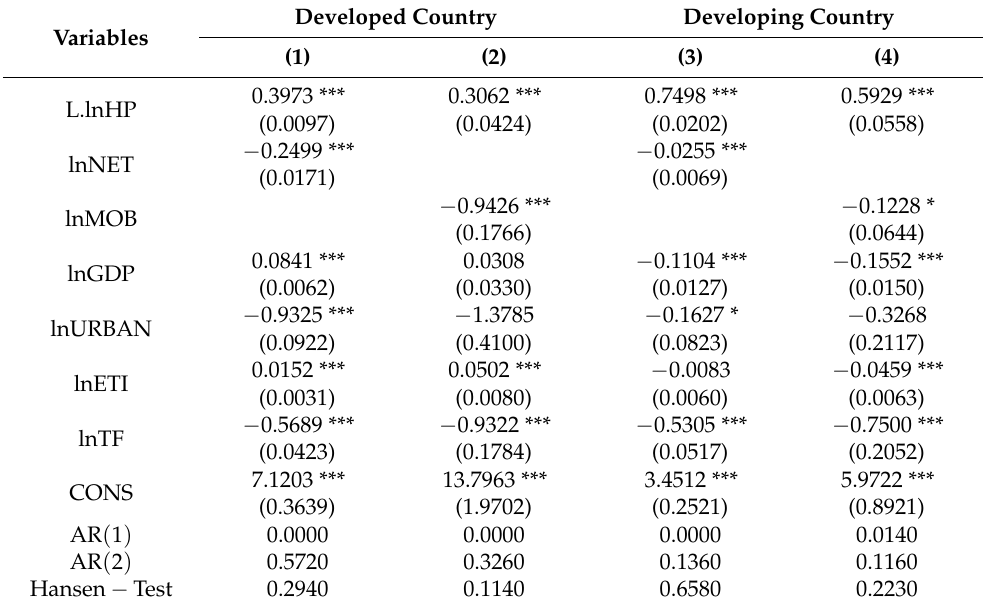
Table 4. Results of the heterogeneity test based on the economic development